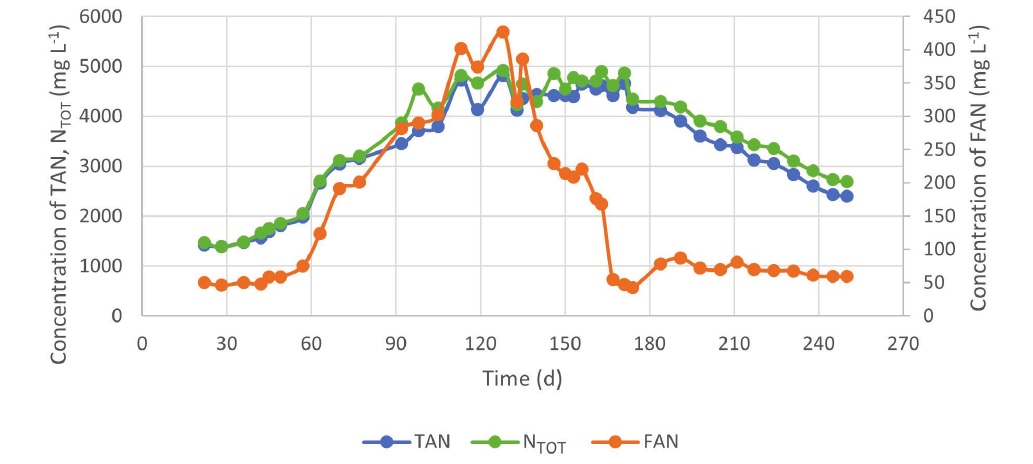
), total ammonia nitrogen (TAN), and free ammonia nitrogen (FAN) TOT